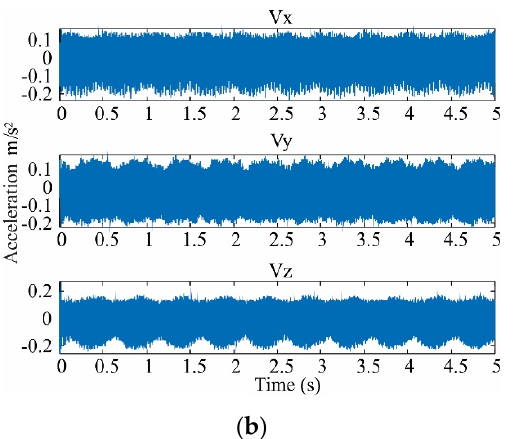
Figure 7. Vibration signals acquired in three directions for ( a ) healthy condition and ( b ) damage of 35 SCTs.